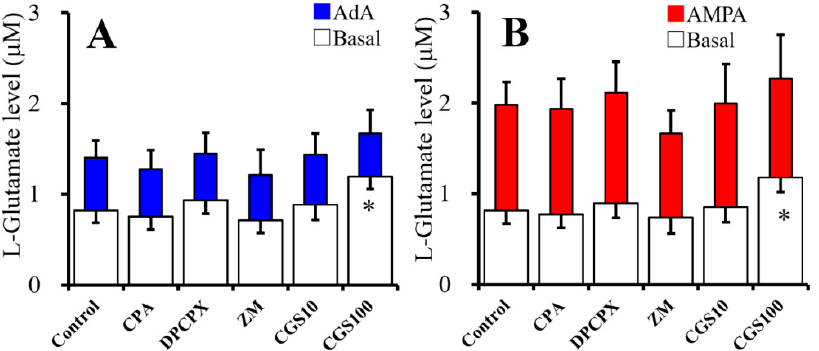
Figure 3. Acute effects of adenosine receptor agents on astroglial L-glutamate release. Figure 3A,B indicates effects of acute administration of N6-cyclopentyladenosine (CPA) (10 nM), 8-cyclopentyl-1,3-dipropylxanthine (DPCPX) (100 nM), ZM241385 (ZM: 100 nM), and CGS21680 (CGS: 10 and 100 nM) on basal (opened), 1 µ M AdA-evoked ( A , blue), and 100 µ M AMPA-evoked ( B , red) L-glutamate release, respectively. Ordinates indicate mean levels of L-glutamate ( µ M) ( N = 6). * p < 0.05; relative to control by one-way ANOVA with Tukey’s post hoc